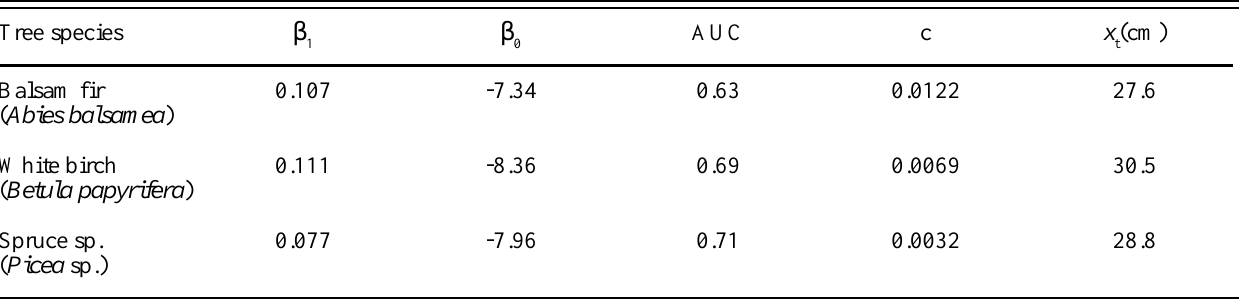
) for the occurrence of nonexcavated cavities t